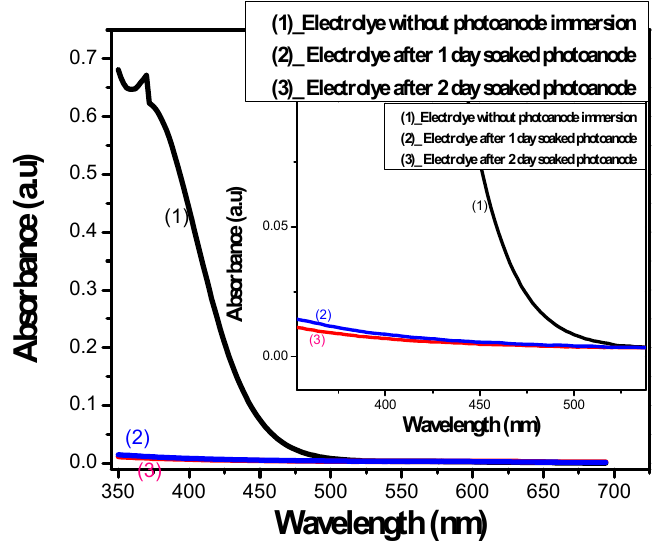
Figure 2. The absorption spectrum of polysulfide electrolyte before and at specific times after photoanode immersion.